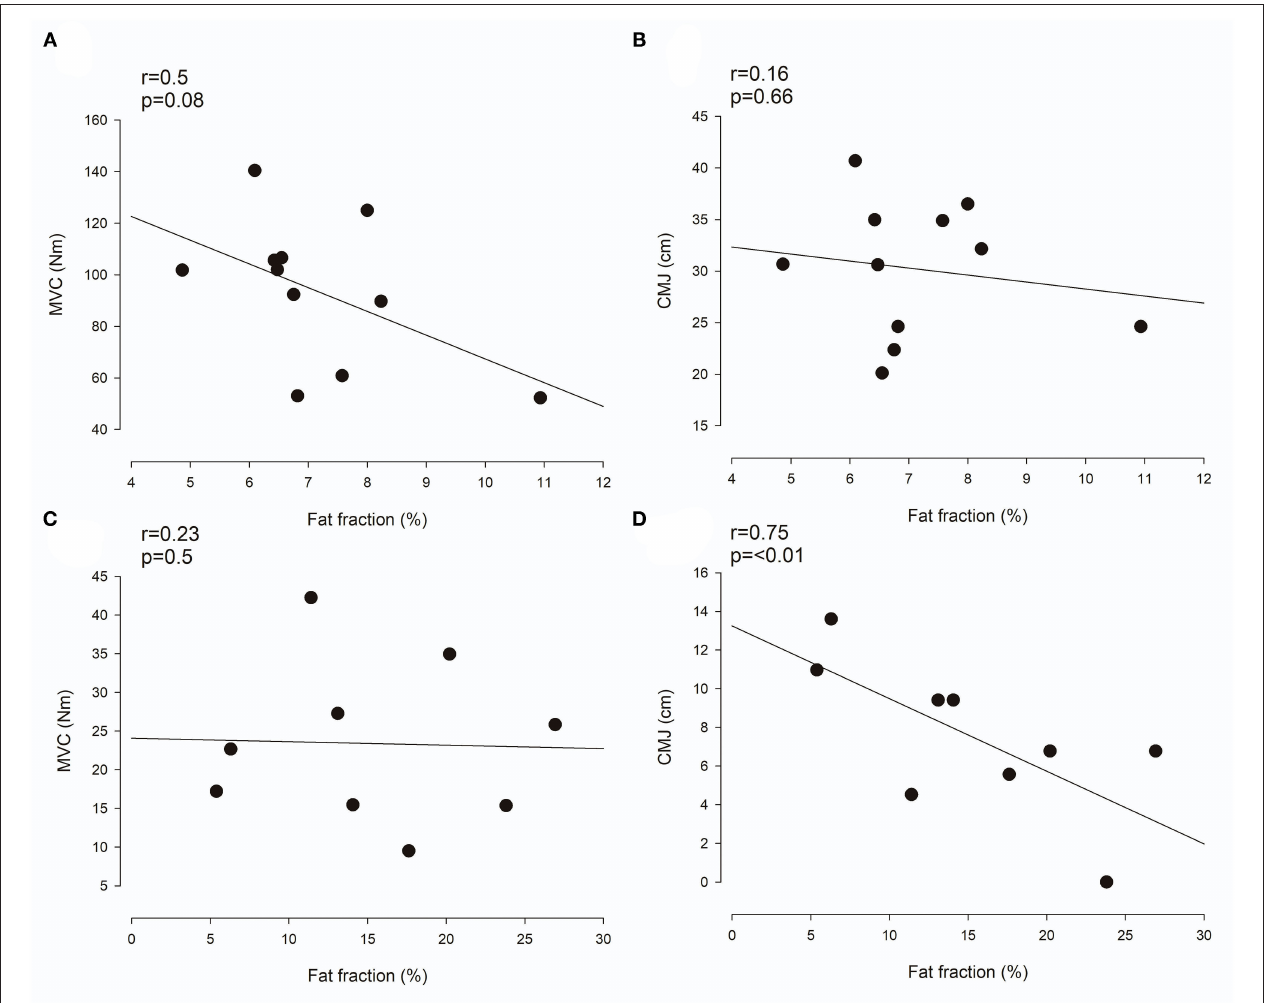
FIGURE 4 | Relationship between muscle composition and function. (A,C) Shows the correlation between the mean fat fraction in the triceps surae muscles and maximal voluntary contraction (MVC) in neurologically intact (NI) adults (A) and adults with Cerebral Palsy (CP) (C) . (B,D) show the correlation between the mean fat fraction in the triceps surae muscles and countermovement jump (CMJ) in NI adults (B) and adults with CP (D) . Each plot shows the trend line as well as individual data